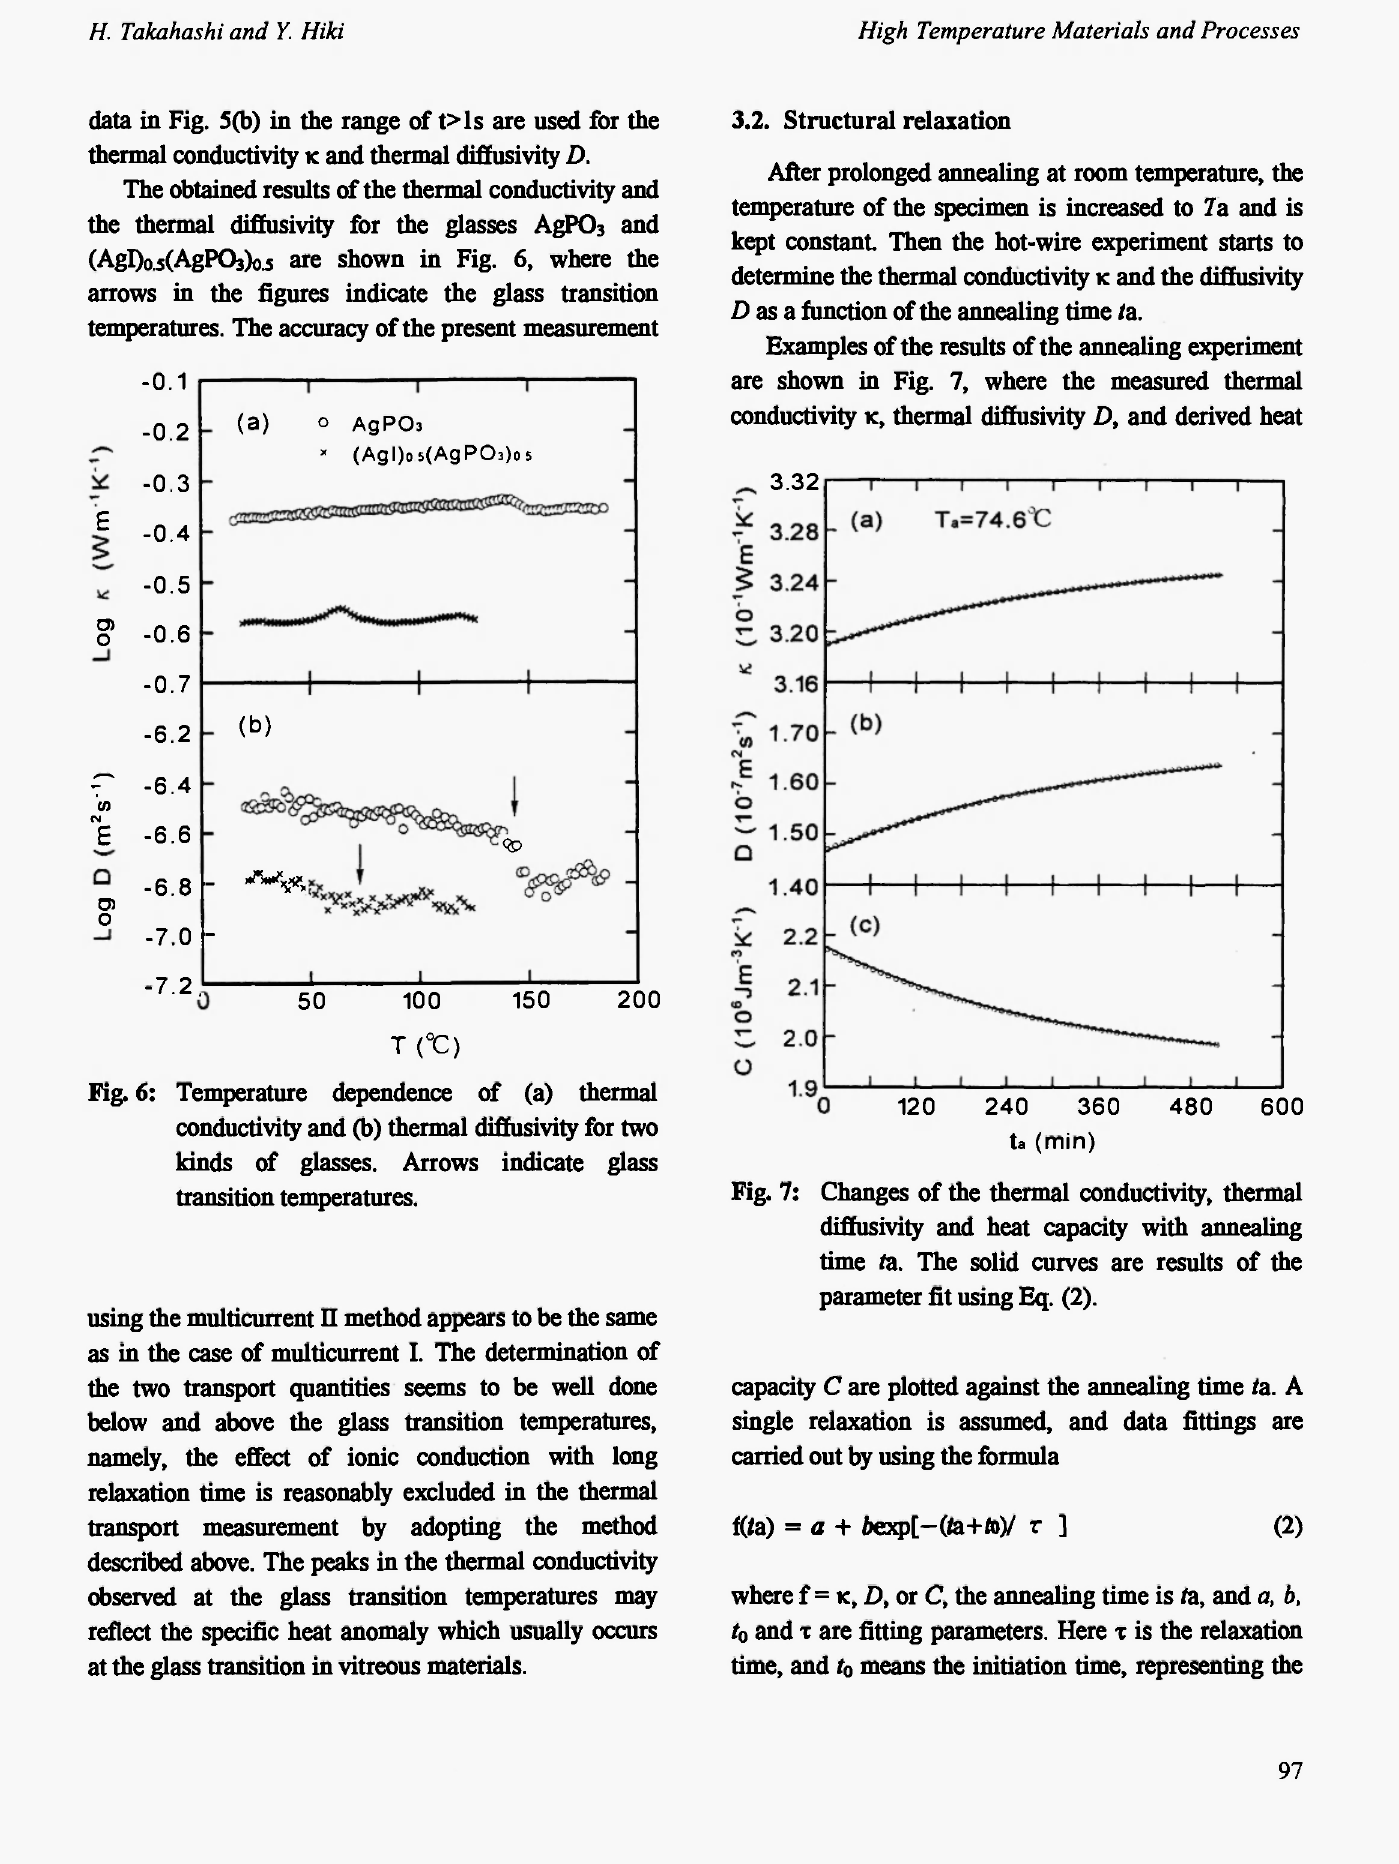
diflusivity and heat capacity with annealing time ta. The solid curves are results of the parameter fit using Eq.